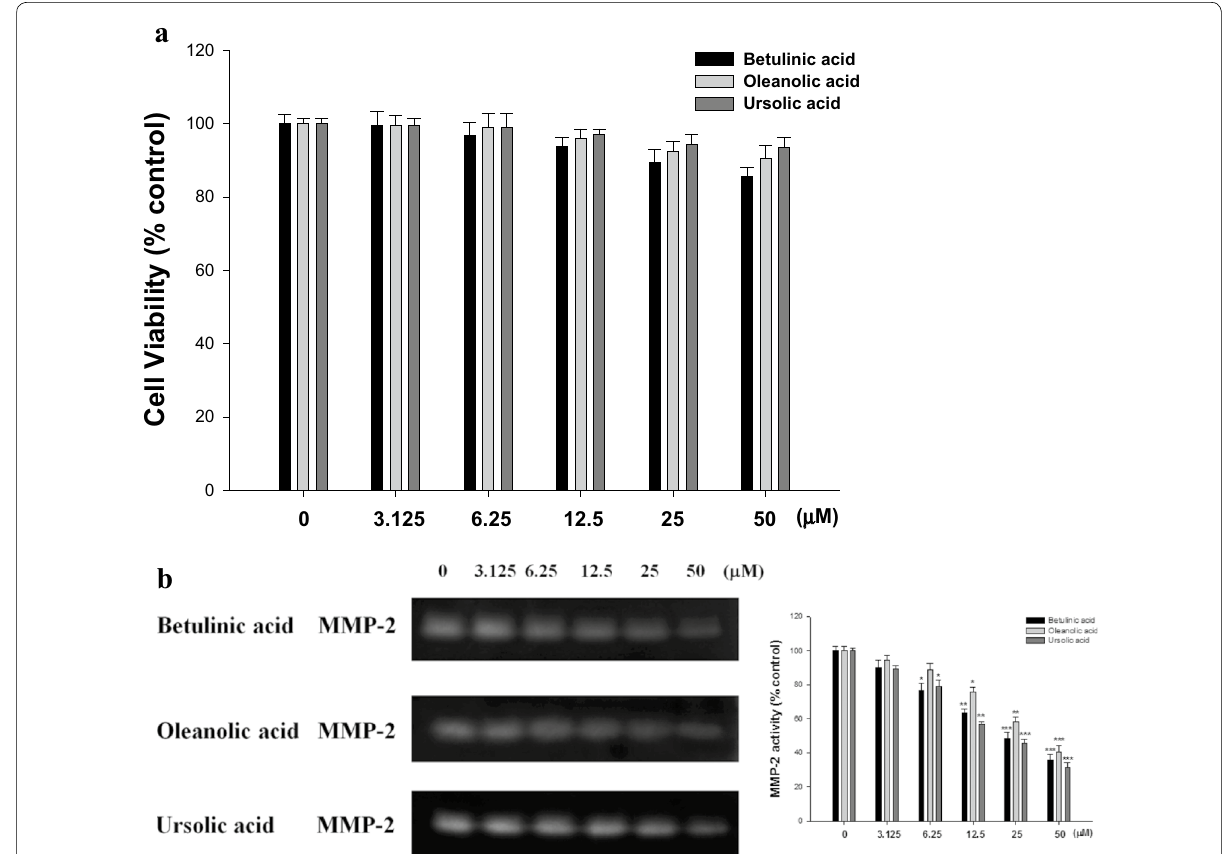
Fig. 6 Effects of betulinic acid, ursolic acid, and oleanolic acid on SK‑Hep1 cell MMP‑2 activity. The cells were incubated for 24 h in the absence or present of betulinic acid, ursolic acid and oleanolic acid (0, 3.125, 6.25, 12.5, 25, and 50 μM). After treatment, cell viability assay was performed using MTT assay. Optical density was determined at 570 nm and is expressed as cell survival relative to control. The conditioned media were collected, and MMP‑2 activity was determined by gelatin zymography. MMP‑2 activity was quantified by densitomeric analysis. The data were presented as mean SD for three different experiments performed in triplicate. * p < 0.05, ** p < 0.01, and *** p < 0.001 was compared with untreated control ±